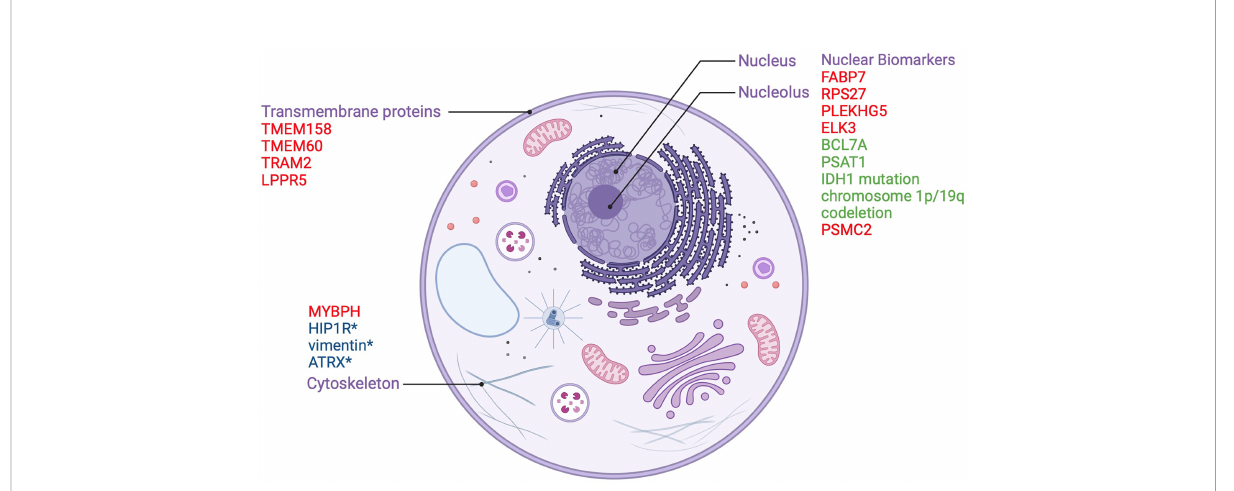
FIGURE 1 Nuclear and transmembrane biomarkers as prognostic factors in gliomas. Biomarkers in red are poor prognostic factors. Biomarkers in green are good prognostic factors.*used to distinguish between oligodendroglioma and